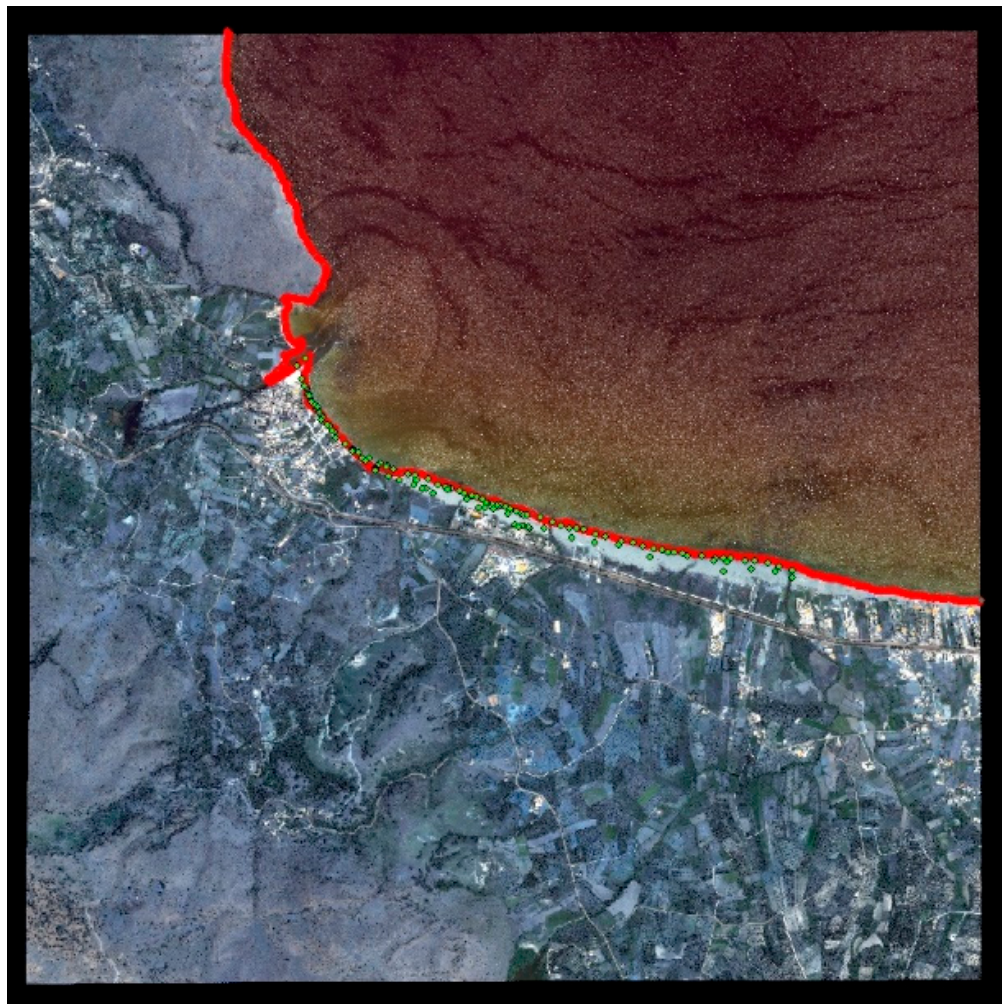
Figure 13. The red line is our estimated coastline, while the green points are the ground truth points taken from the GPS receiver. These points are transferred to the immediate coastline and the shortest distance from the shore is used for each point.